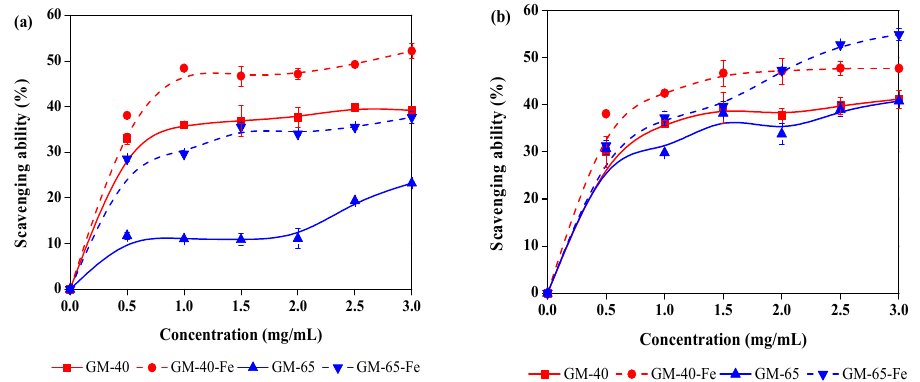
Figure 6. In addition, the antioxidant activity of the original galactomannan preparations (GM-40 and GM-65) were also analyzed for comparison.